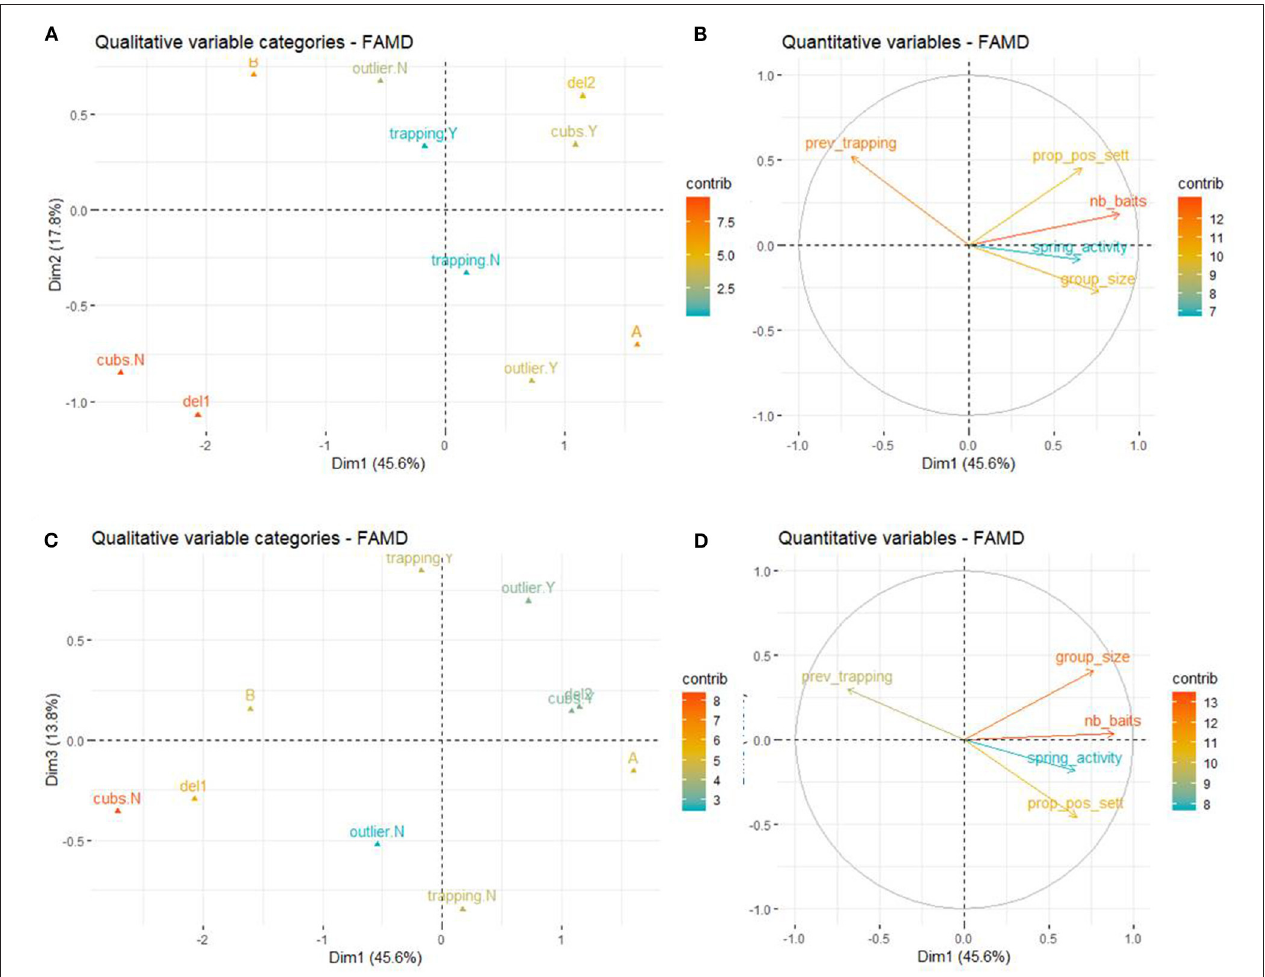
FIGURE 5 | Results of the FAMD at the social group level. (A) Graph of the qualitative variables plotted on dimensions 1 and 2. (B) Graph of the quantitative variables plotted on dimensions 1 and 2. (C) Graph of the qualitative variables plotted on dimensions 1 and 3. (D) Graph of the quantitative variables plotted on dimensions 1 and